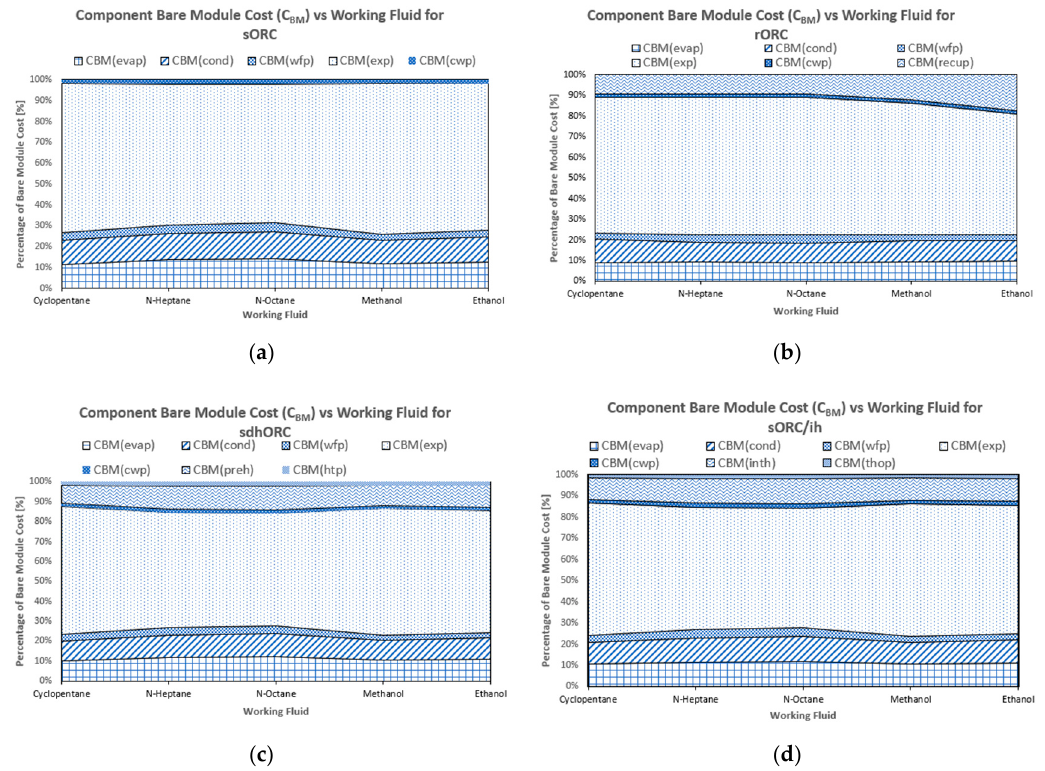
Figure 6. Percentage of total cost for ORC components ( a ) sORC; ( b ) rORC; ( c ) sdhORC; ( d ) sORC/ih.